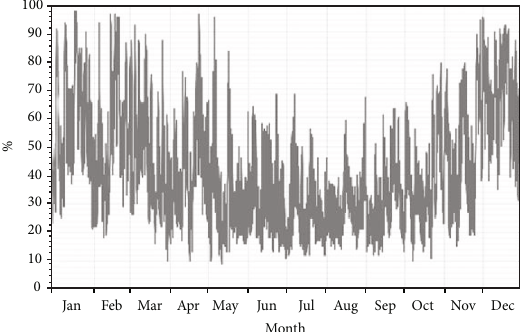
Figure 7: Annual humidity rate for Tehran during the months of the year [http://www.tehranmet.ir/].